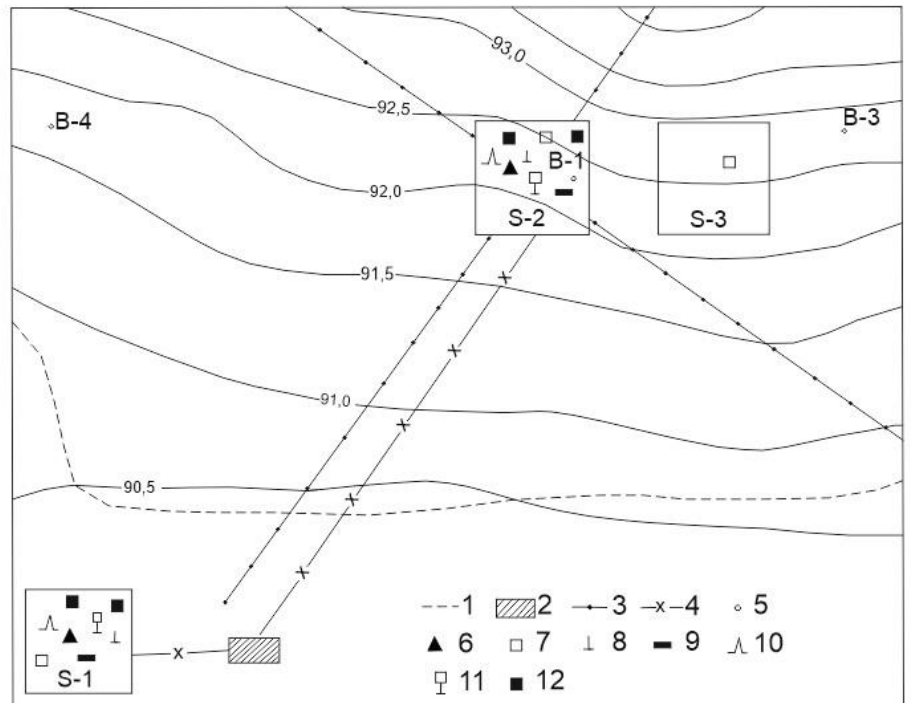
Figure 3. Scheme of Experimental Sites at the Zeleny Lug Heat Balance Station [36]. Plot S-1—natural plot; plot S-2—on the embankment; plot S-3—with periodically compacted snow cover. (1) Alluvial boundary; (2) heat balance pavilion; (3) routes and points of snow surveys; (4) communication and power supply line; (5) thermometric borehole; (6) actinometric stand; (7) thermocouple thermoset in combination with thermoelectric device; (8) frost gauge; (9) heat meter; (10) gradient setting; (11) psychrometric booth; (12) evaporators and rain gauges.